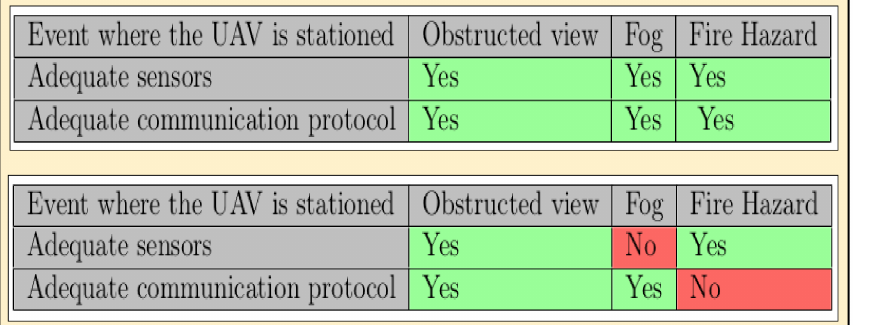
Figure 32. Full driver notification assistance (i.e., sensors and communication protocols present) vs. partial notification assistance (i.e., sensors or communication protocol missing). Green color denotes ideal situation where full assistance is achieved. Red color denotes partial or no driving assistance due to absence of correct sensor or correct communication